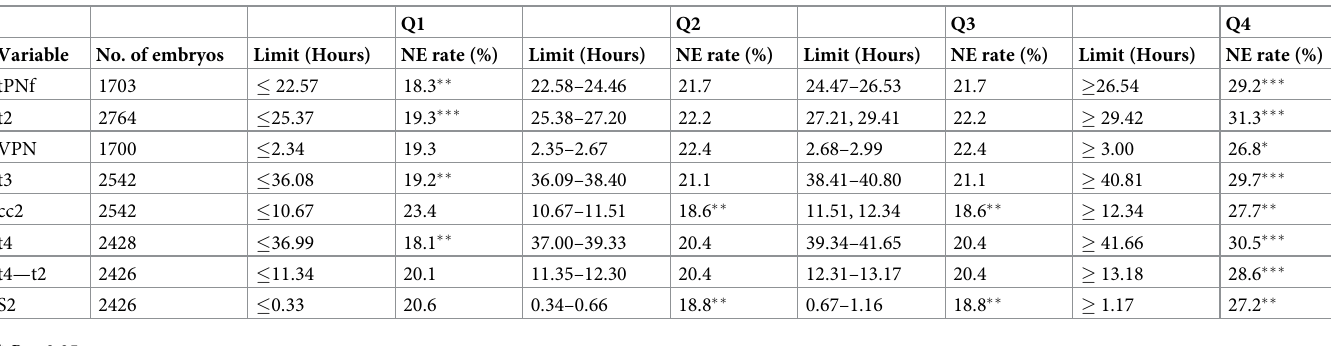
Table 3. Timing of the morphokinetic variables from 2769 transferred embryos grouped in quartiles Q1, Q2, Q3 and Q4 with nucleation error (NE) occurrence. Q1 Q2 Q3 Q4